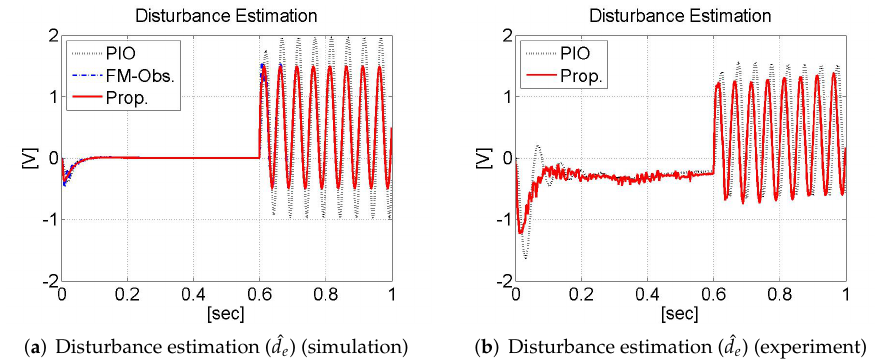
Figure 7. Results of disturbance estimation.